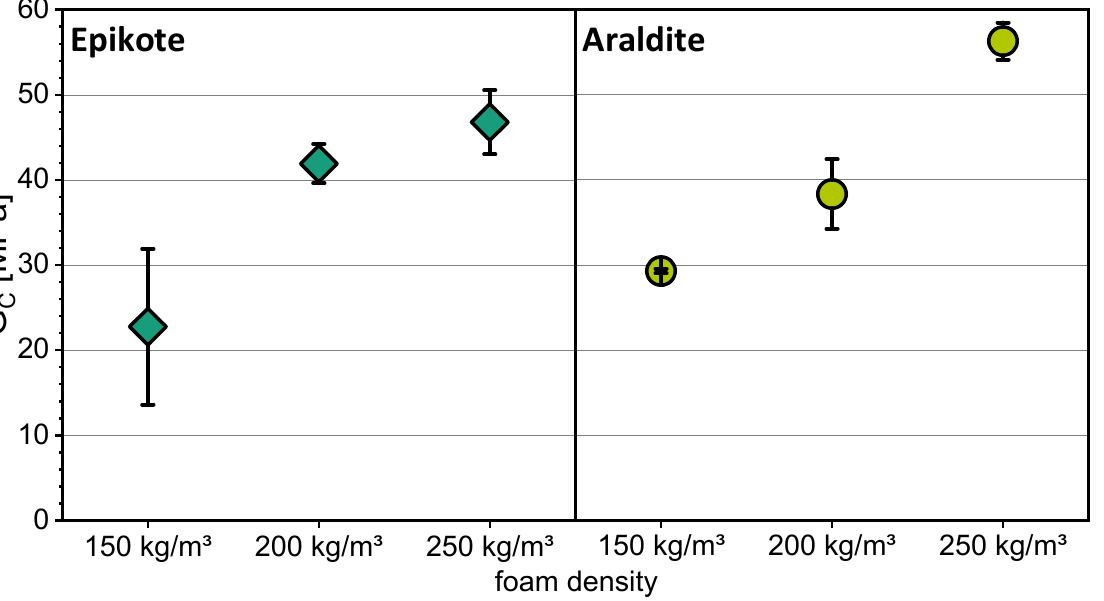
Figure 9. Core shear stiffness of the sandwich structures for the Epikote resin system (left) and the Araldite resin system (right).